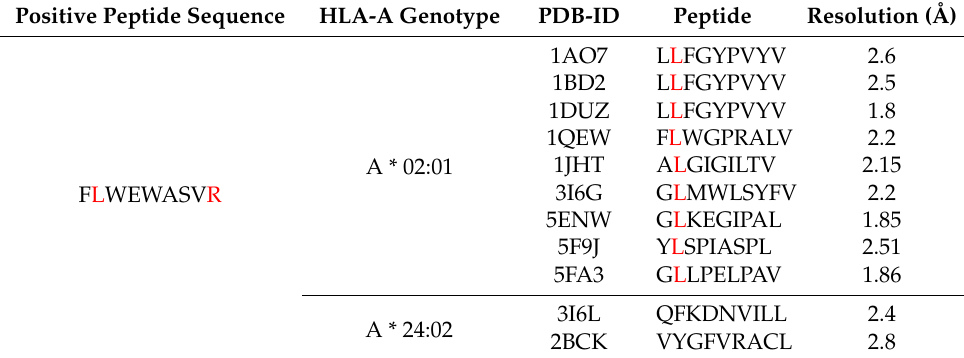
Table 1. Selection of HBV-positive peptide and HLA-A genotype. Positive Peptide